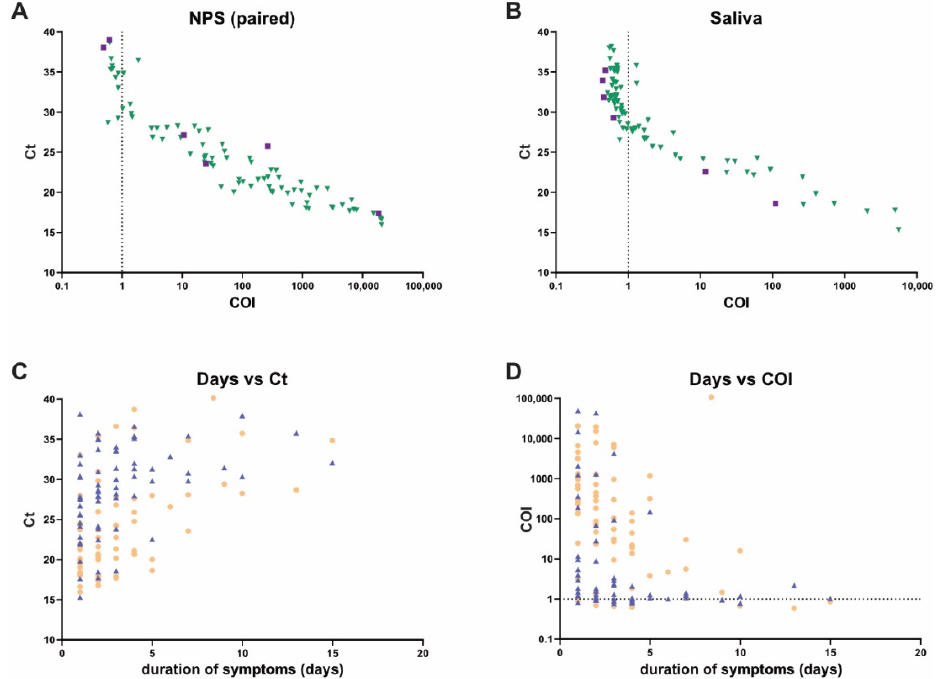
Figure 3. SARS-CoV-2 detection in asymptomatic and symptomatic disease stages. ( A , B ) Analysis of paired NPS ( A ) and saliva ( B ) samples from asymptomatic (N = 6) and symptomatic (N = 77) individuals that tested positive for SARS-CoV-2 by RT-PCR. Roche Elecsys Anti-SARS-CoV-2 Antigen assay results (COI value) and corresponding cobas SARS-CoV-2 IVD test results (Ct value) are depicted. Cutoff of the antigen test is indicated by a dotted line. Green triangles: asymptomatic, violet squares: symptomatic. Comparison of duration of symptoms (days) and outcome of cobas SARS-CoV-2 IVD test ( C ) or Roche Elecsys Anti-SARS-CoV-2 Antigen assay ( D ) in paired symptomatic SARS-CoV-2 positive NPS (orange circles, N = 65) and saliva (blue triangles, N = 65) samples. For 12 of the 77 symptomatic patients, no information on duration of symptoms was available.